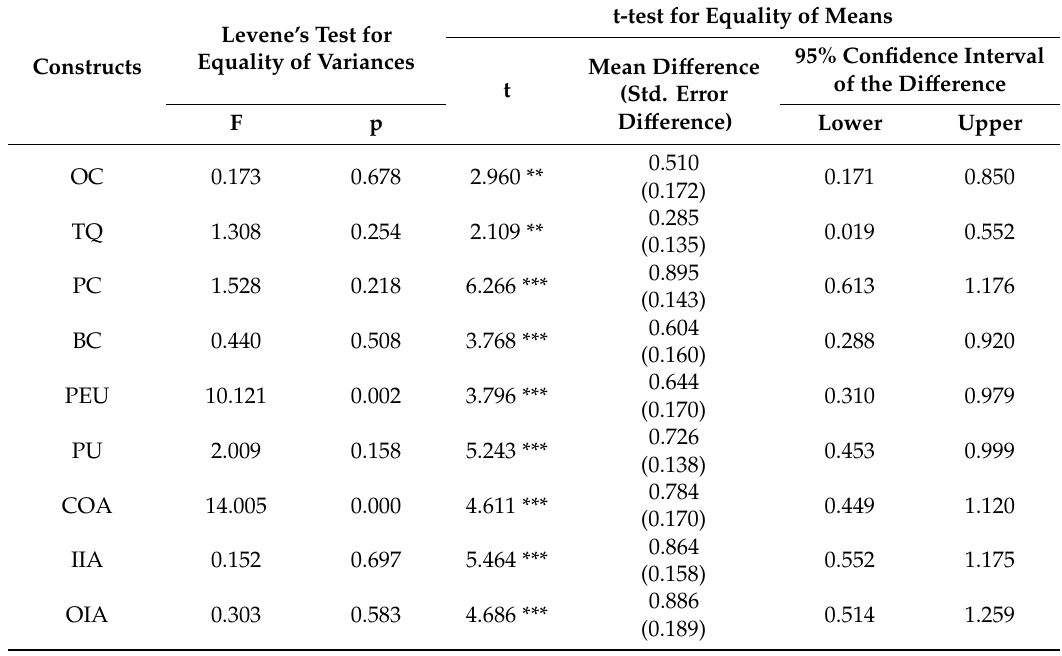
Table 7. T-test results of BIM Acceptance between 2012 and